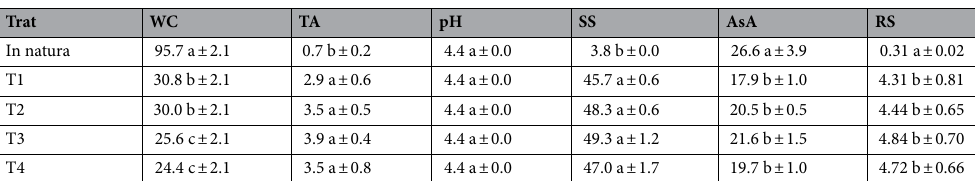
Table 2. Physical–chemical characterization of fresh and dried tomatoes in a handmade solar dryer. Means followed by the same letter in the columns did not differ by the Tukey test (p < 0.05). T1 no bleaching,